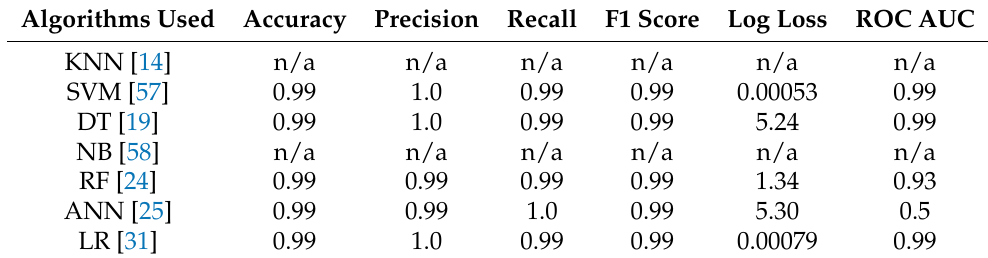
Table 39. DoS UDP weighted classes results.